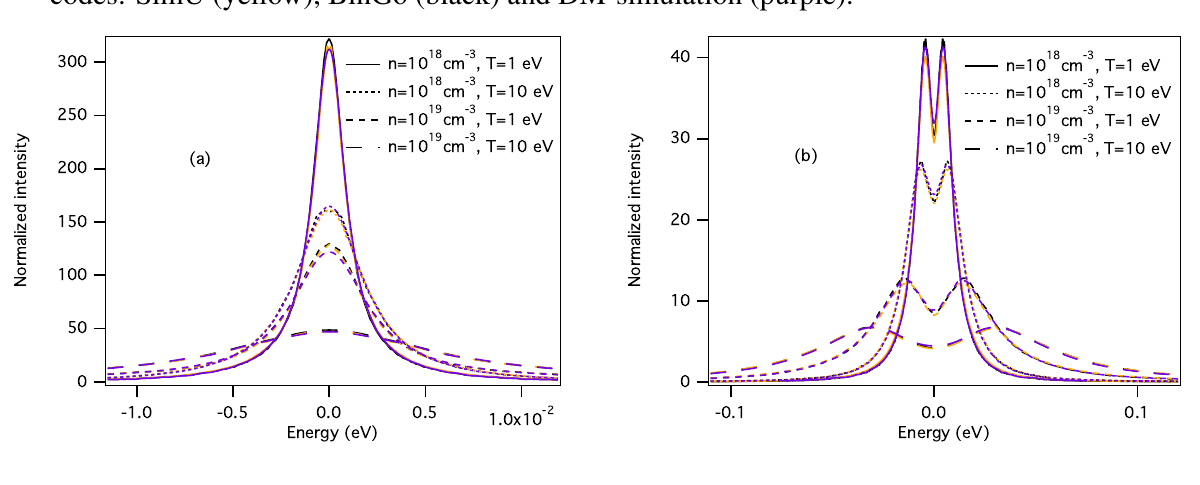
Figure 6. Spectral line shapes of the Lyman- α ( a ) and - β ( b ) line in a time-dependent field created by interacting protons. Comparisons of the results obtained by the three simulation codes: SimU (yellow), BinGo (black) and DM-simulation (purple).